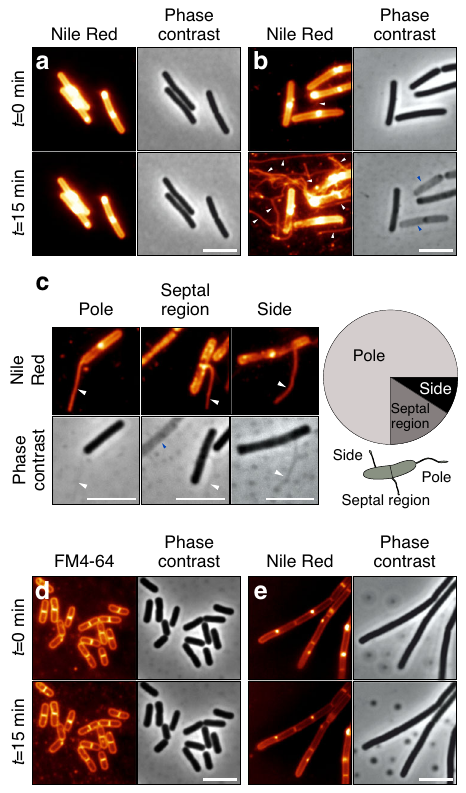
Fig. 1 NT formation in exponential and stationary phase. These images were acquired by fl uorescence microscopy; the corresponding phase- contrast images are also shown. For de fi nition of t = 0 refer to Mat & Met. a Exponentially grown wt B. subtilis (LK1432) cells prepared by the GAG method. b Exponentially grown wt B. subtilis (LK1432) cells prepared by the P-GLG method. c One-hundred exponentially growing wt B. subtilis (LK1432) cells bearing NTs were analyzed. Most NTs emanated from the cell poles (75 NTs), followed by NTs from the septal region (16 NTs) and the sides (9 NTs). The positions of NT attachment to the rod-shaped cells were not uniformly distributed over the cell surface ( p < 0.001, custom test — see Quanti fi cation and statistical analysis). d Stationary phase wt B. subtilis (LK1432) cells prepared by the P-GLG method but to stain the membranes, FM4-64 was used instead of Nile Red, as Nile Red poorly stains membranes of cells from this phase (Supplementary Fig. 2d). e Exponentially grown Δ sigD (LK1873) cells prepared by the P-GLG method. The images were taken at 0 and 15 min time points. White arrows indicate NTs, blue arrows indicate ghost cells in the phase-contrast images. The membrane stain (false colored glow, FM4-64 or Nile Red) is indicated above the images. Scale bar = 5 μ m. All experiments ( a – e ) were conducted in at least three biological replicates with similar strain used: PY79 behaved like BSB1 (Supplementary Fig. 2a – c).